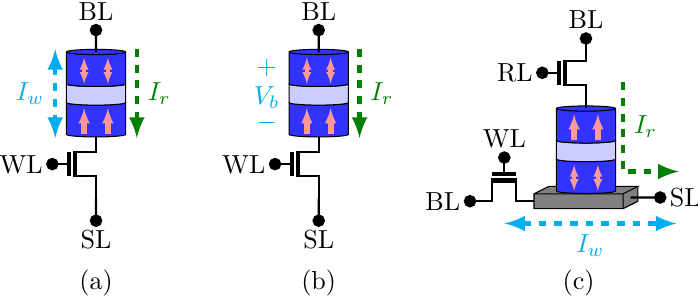
Figure 3. Memories devices: ( a ) STT-MRAM ( b ) VCMA-MeRAM ( c )